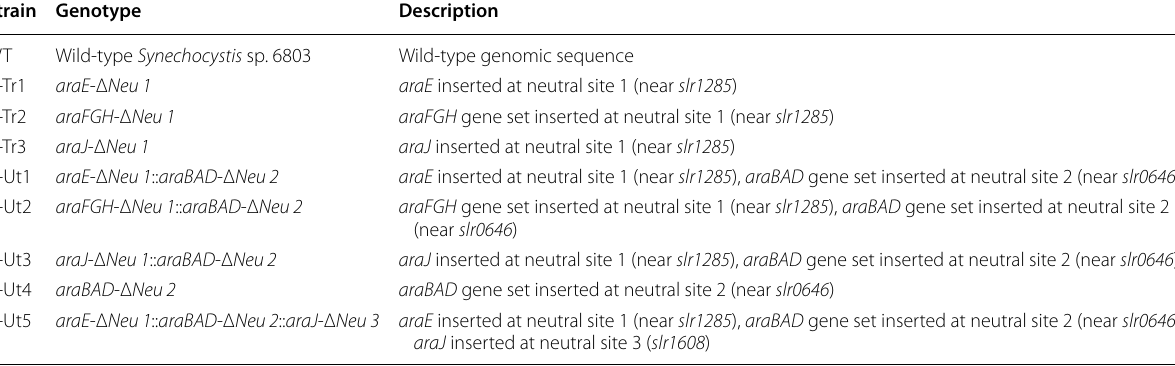
Table 1 Synechocystis strains used in this study Strain